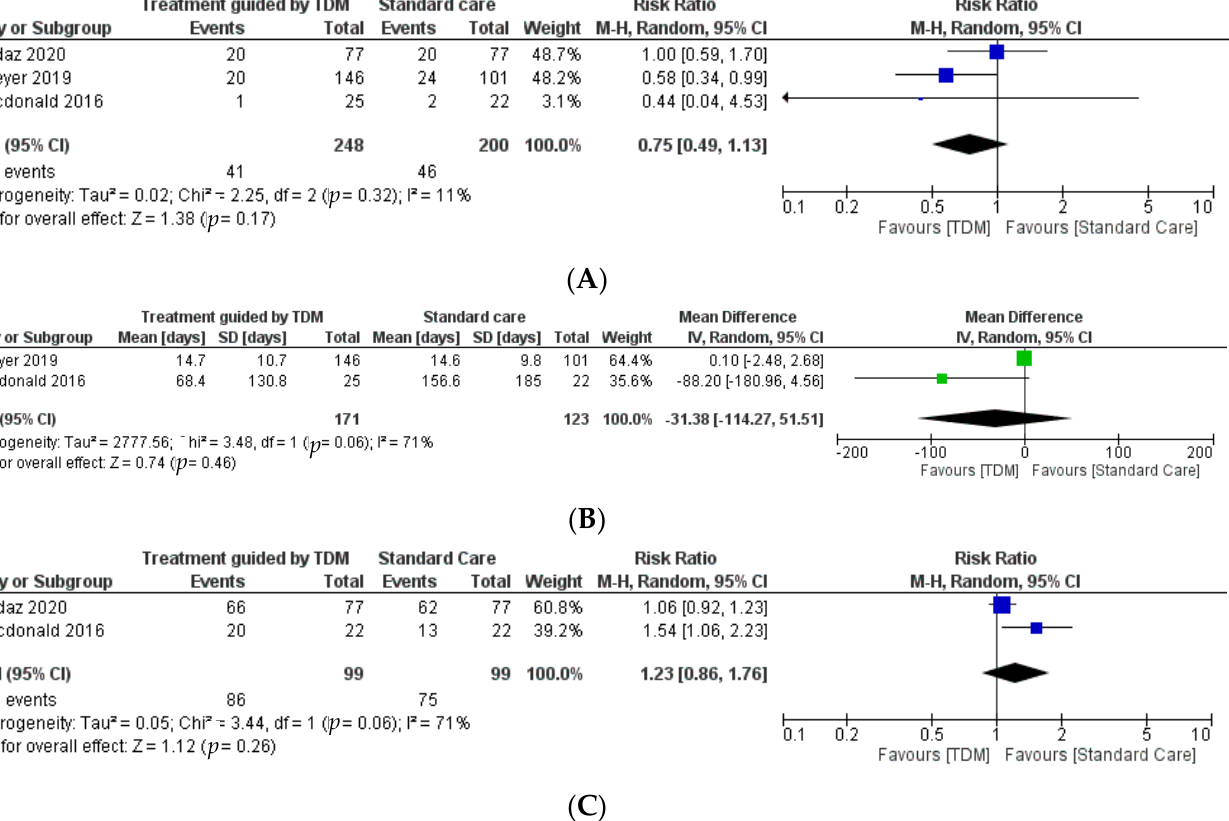
Figure 2. Forest plots. Therapeutic drug monitoring (TDM) cohort versus standard care for in-hospital mortality (obser- vational) ( A ). TDM cohort versus standard care for microbiological eradication (observational) ( B ). TDM cohort versus standard care for intensive care unit (ICU) length of stay in days (observational) ( C ).